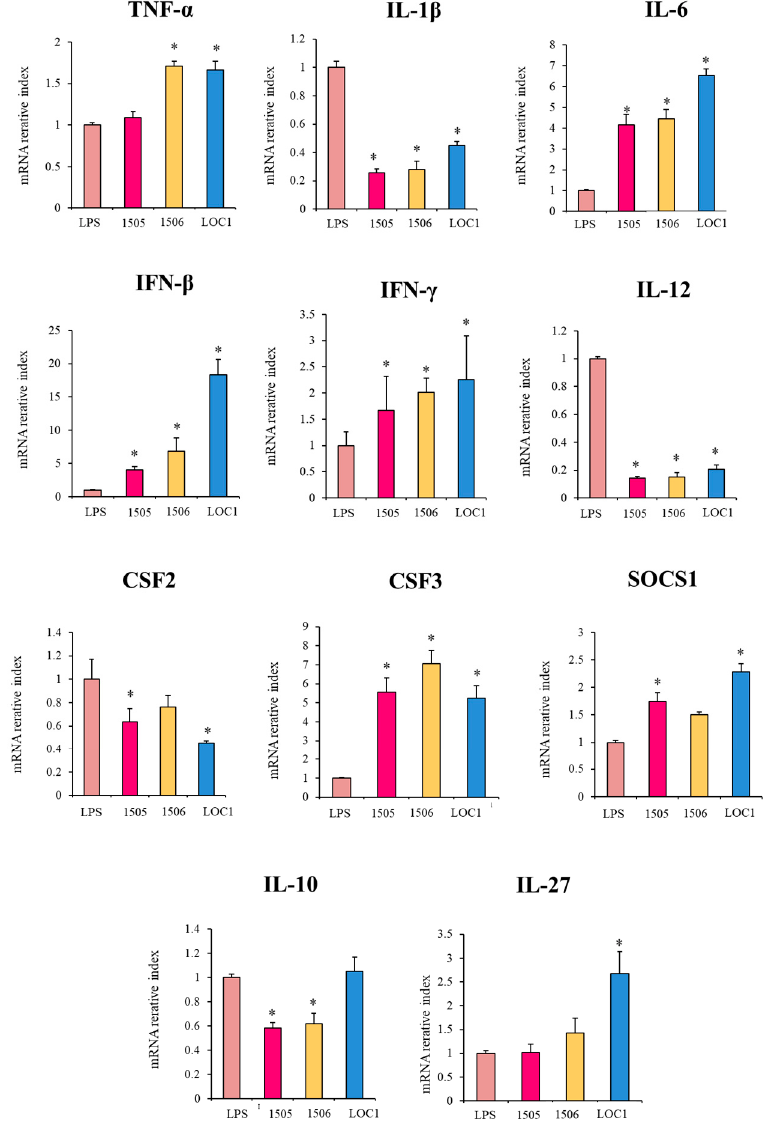
Figure 4. Effect of Lactiplantibacillus plantarum LOC1 in murine RAW macrophages stimulated with the Toll-like receptor 4 (TLR4) agonist lipopolysaccharide (LPS). Macrophages were treated with L. plantarum LOC1 and then challenged with LPS. The expression of immune factors was determined 3 h after LPS stimulation. Macrophages treated with the probiotic strains Lacticaseibacillus rhamnosus CRL1505 or L. plantarum CRL1506 and then challenged with LPS were used for comparisons. Results represent data from three independents. Asterisks indicate significant differences between the indicated groups and LPS-challenged control macrophages, (*) p < 0.05.